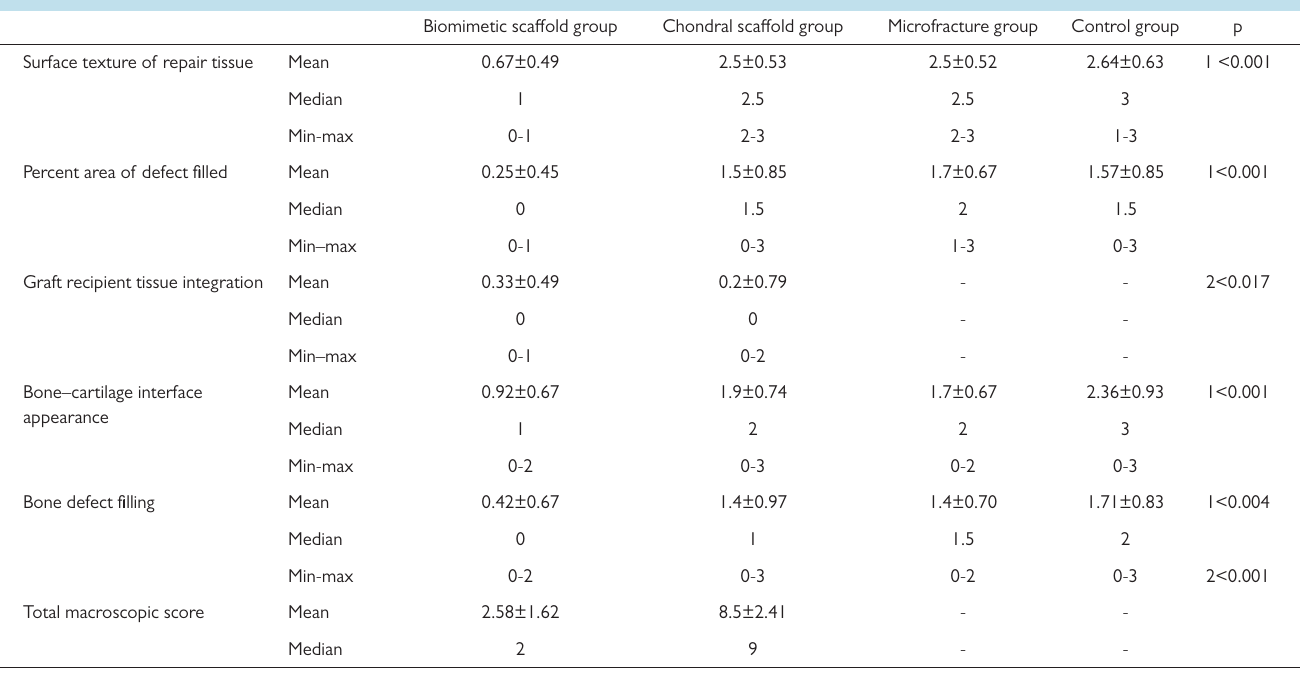
Table 4. Mean, median, and minimum and maximum values of the macroscopic scores (Modified Fortier